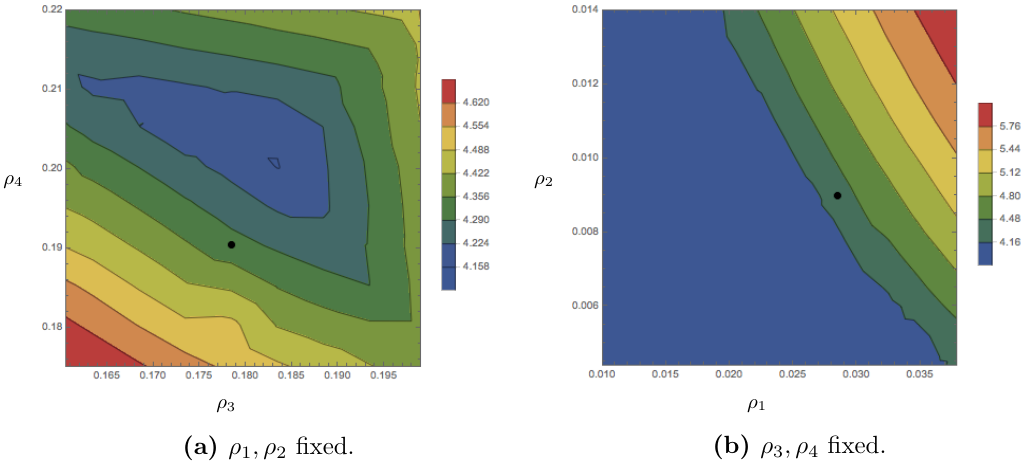
Figure 18 . The quantity (cid:1) L in the neighborhood of ^ (cid:26) (black